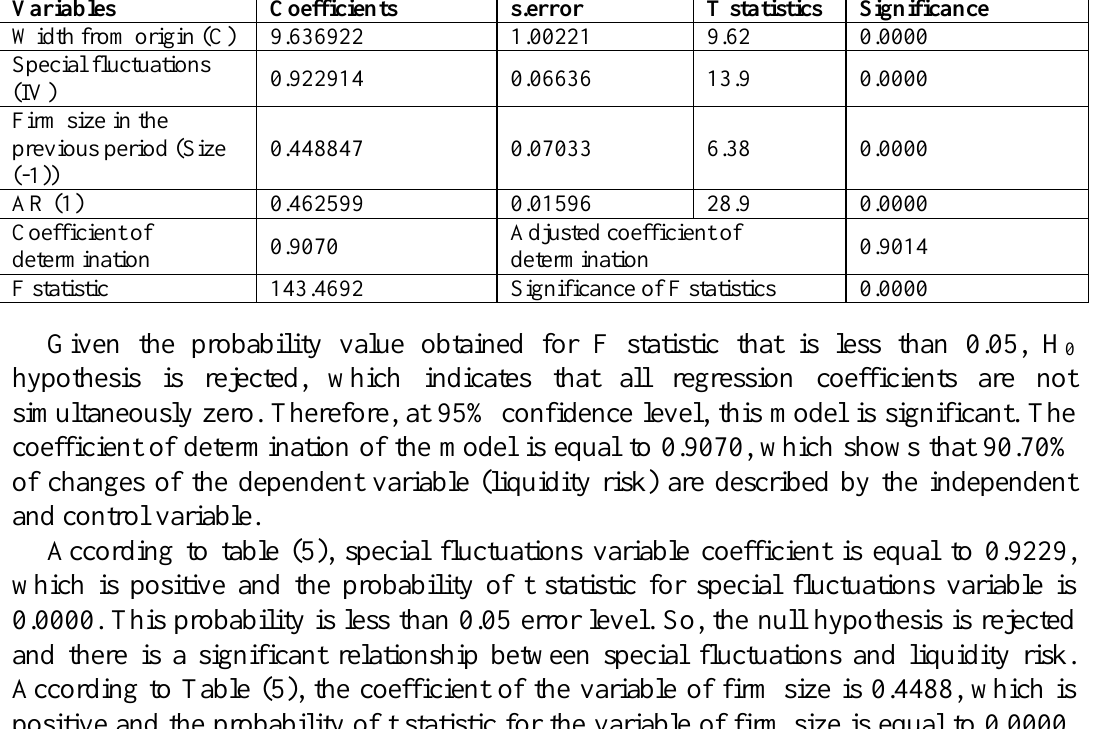
Table 5: Results of data analysis in order to test the first research hypothesis